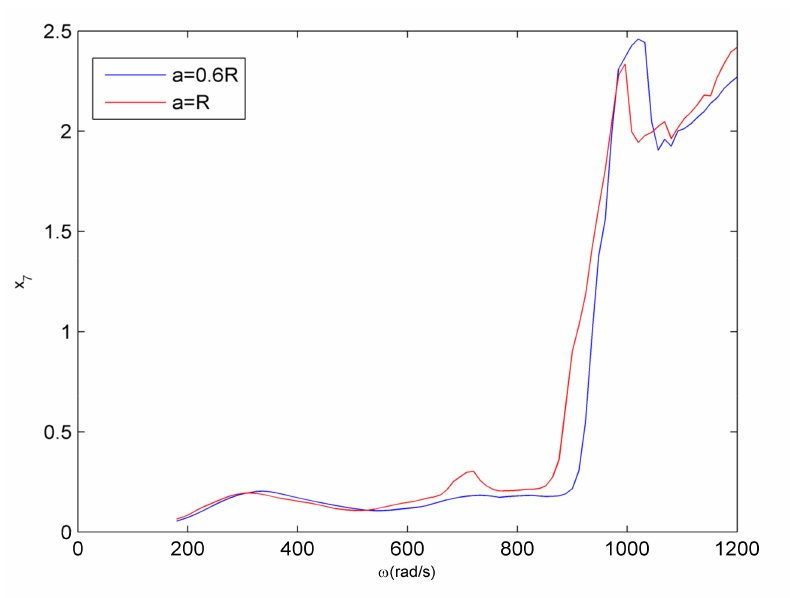
Figure 15. Comparison of the amplitude–frequency